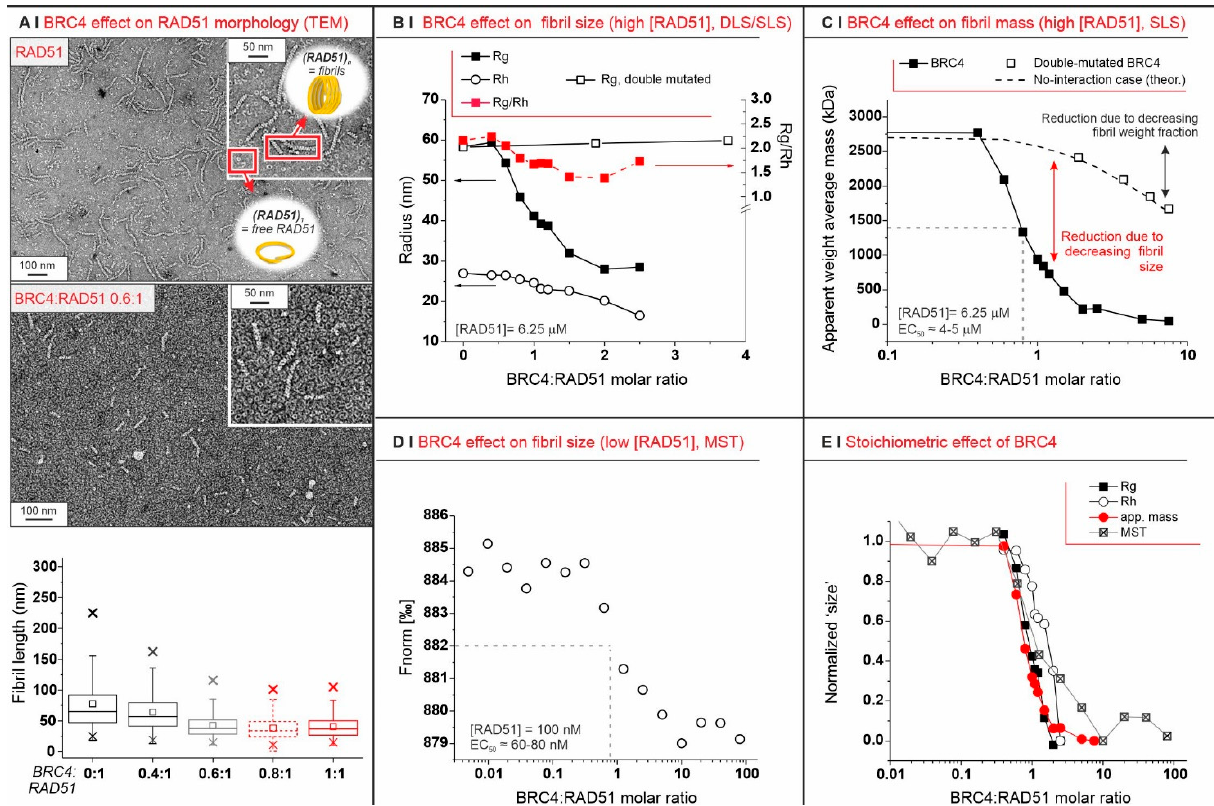
Figure 1. ( A ) Negative staining TEM of 0.1 mg/mL RAD51 fibrils, alone (top) or in the presence of BRC4 (middle, RAD51/BRC4 1:0.6 molar ratio), clearly indicates the latter as an antagonist of RAD51 fibrillation. The fibril length is reported in a box plot as a function of BRC4 concentration (bottom) after fitting TEM data with Gaussian models (see Supporting Information, Figure S3). In the absence of BRC4, most of the fibrils appeared to be 80–200 nm-long, but they may have been fragmented during sample preparation; indeed, static light scattering predicted a higher fibril length (Table S1). ( B ) Evolution of Rg, Rh, and the Rg/Rh ratio (i.e., the aspect ratio) of RAD51 fibrils (6.25 µM = 0.25 mg/mL) upon addition of BRC4 or scBRC4. ( C ) Apparent weight average mass ( 𝐴𝑀 (cid:3050) from SLS measurements: it is the average mass of all colloids in the sample) for RAD51/BRC4 suspensions ((RAD51) = 6.25 µM = 0.25 mg/mL) as a function of the peptide/protein ratio. The dashed line was calculated assuming that a compound of the same mass of BRC4 was added and had no interaction with RAD51. The empty squares refer to SLS measurements performed with a double-mutated form of BRC4. ( D ) MST measurements provide an indication of the size (diffusion coefficient) of RAD51 fibrils, which was reduced with increasing RAD51/BRC4 ratios ((RAD51) = 100 nM = 4 µg/mL). ( E ) SLS (Rg and apparent mass data), DLS (Rh data), and MST measurements ( 𝐴𝑀 (cid:3050) data) all suggest a stoichiometric (1:1) mode of action for the BRC4-induced RAD51 defibrillation.